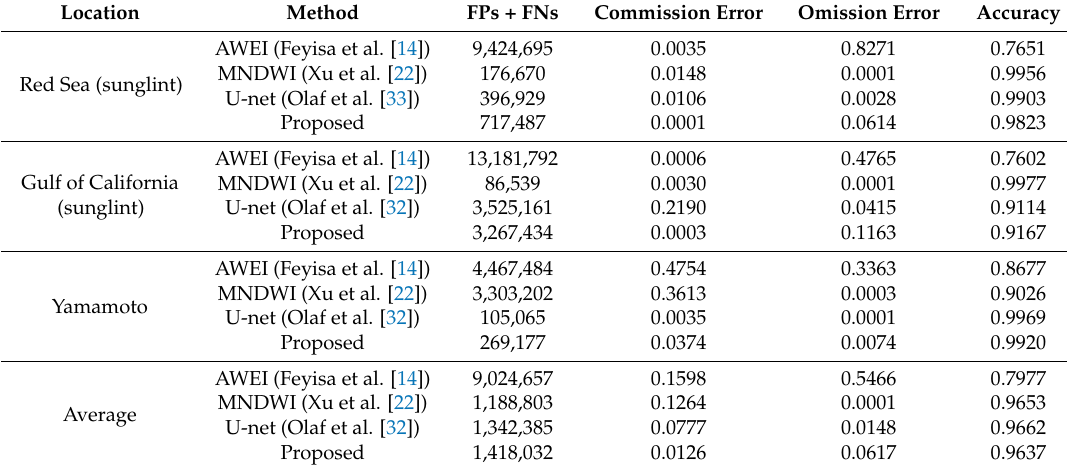
Table 4. Quantitative evaluation of the performance of AWEI, MNDWI, U-net, and PDWF in the case of sunglint-affected and snow/ice-covered